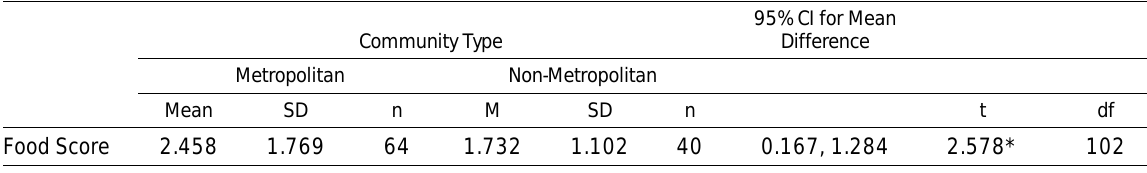
Table 6. Results of t-tests and Descriptive Statistics for Food Score by Community Type